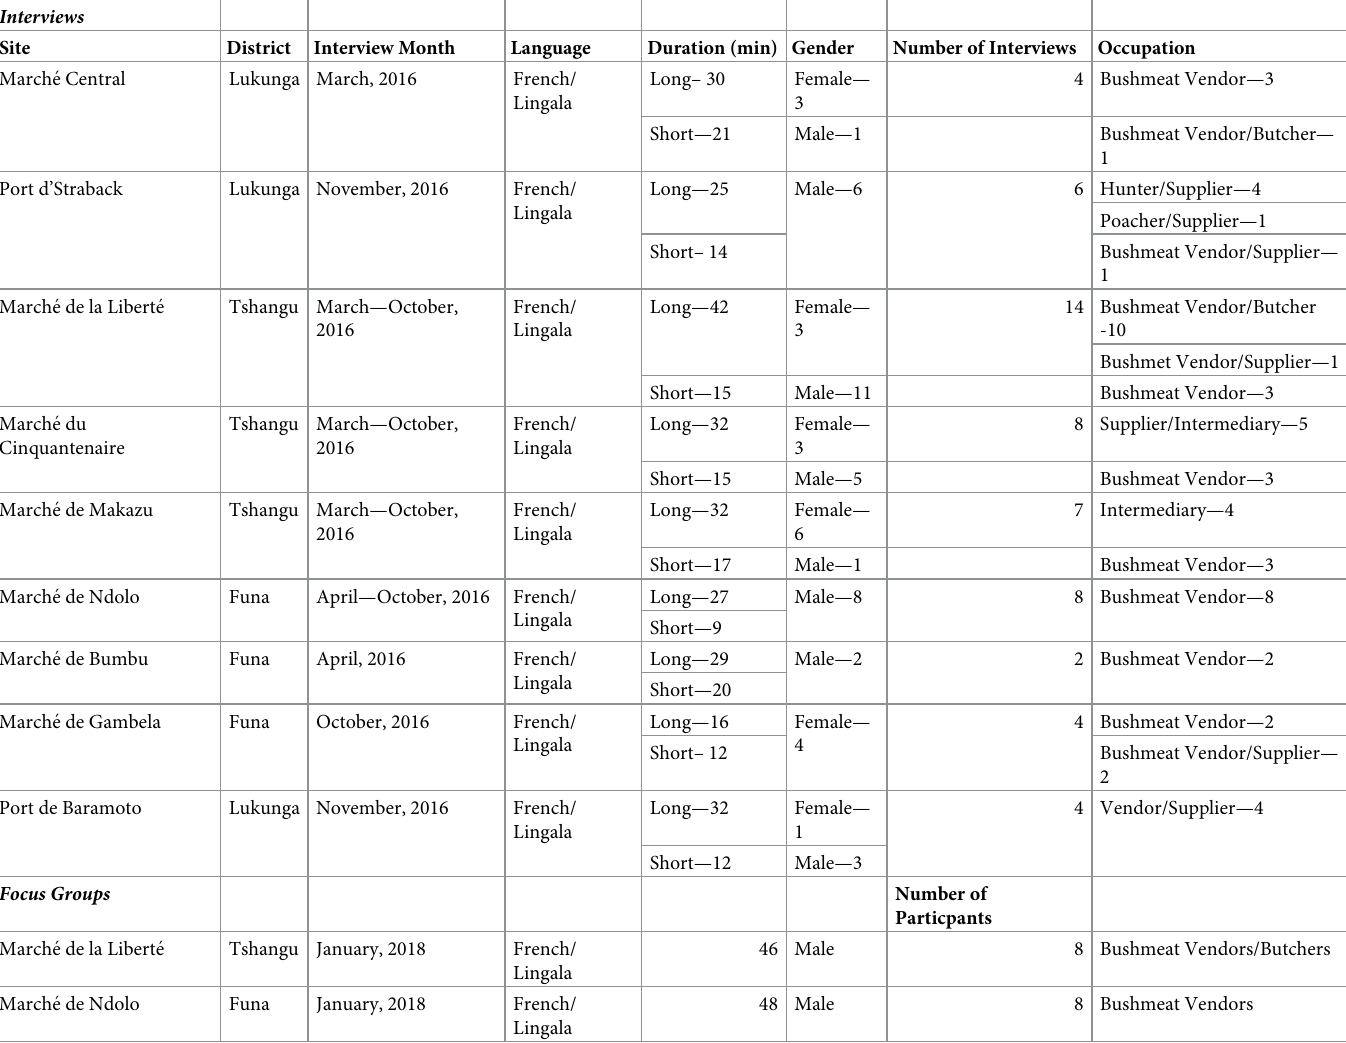
Table 1. Demographic and livelihood characteristics of interview and focus group participants in Kinshasa, Democratic Republic of Congo.